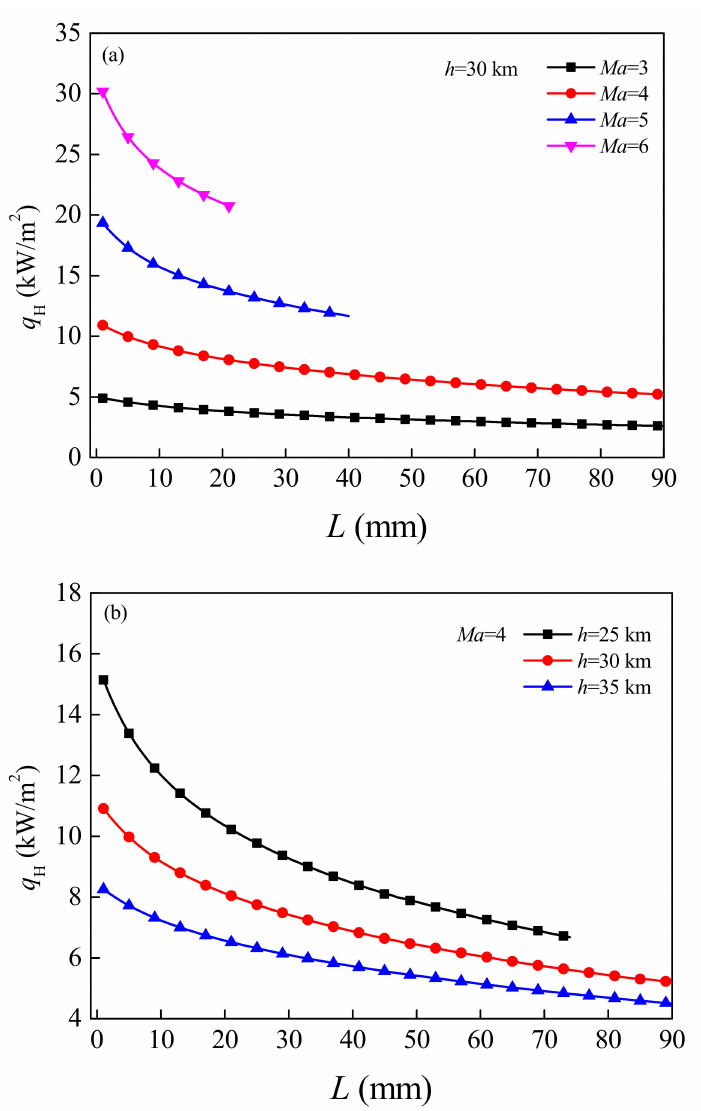
Figure 6. Variation of the heat absorption of the hot end of the TEG changing with the length of the TE legs under different flight Mach numbers ( a ) and flight altitudes ( b